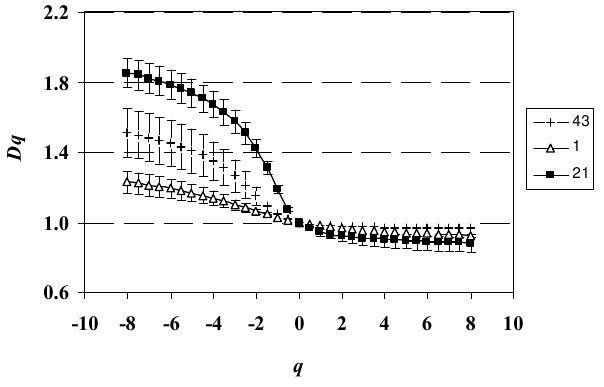
Fig. 6. Selected examples of generalized dimension